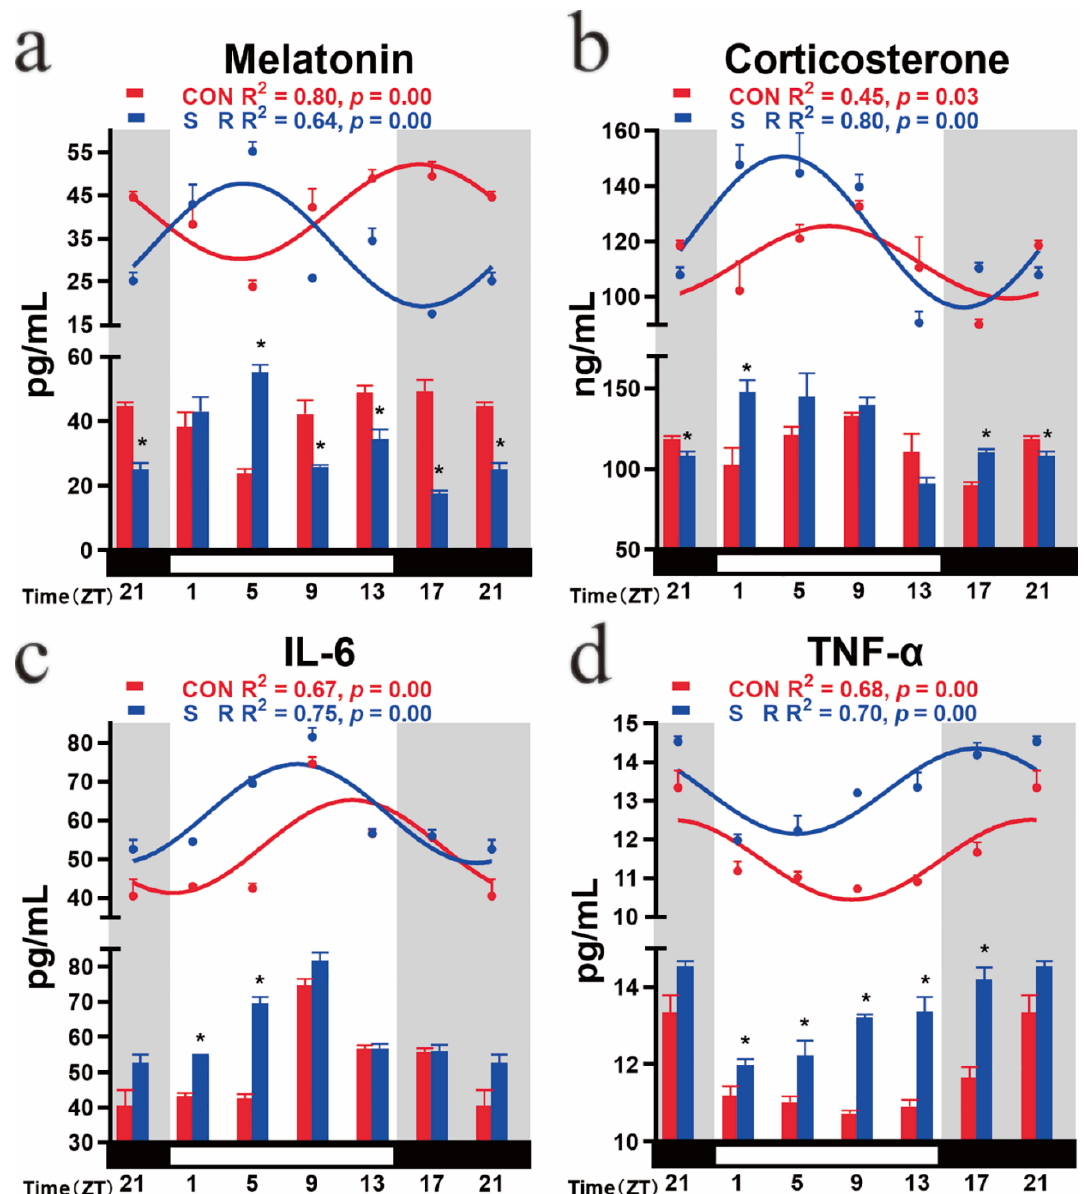
Figure 4. Temporal changes in the plasma melatonin, corticosterone, IL-6, and TNF-α concentrations of mice in the different groups; ( a ) melatonin, ( b ) corticosterone, ( c ) IL-6, ( d ) TNF-α. The horizontal white bar on each figure represents the subjective day, and the black bar represents the subjective night; n = 3 mice per time point. The data are shown as the mean ± SEM. The curve indicates the best fit to the points by cosinor analysis. R 2 values represent the degree of fitting. *: p -values indicate the significance of regression analysis, with significance defined as p < 0.05. The comparison at each time point uses t -tests.